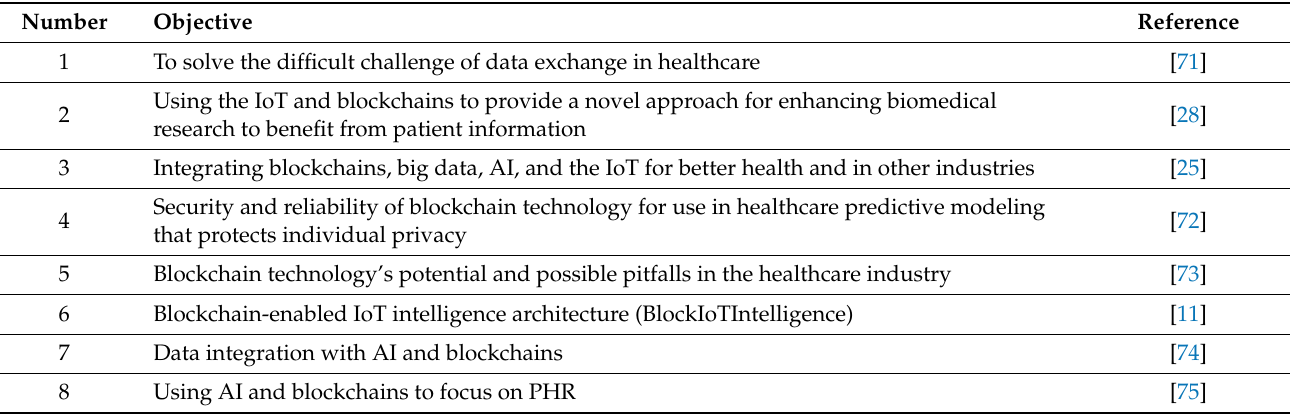
Table 3. Healthcare using blockchains and